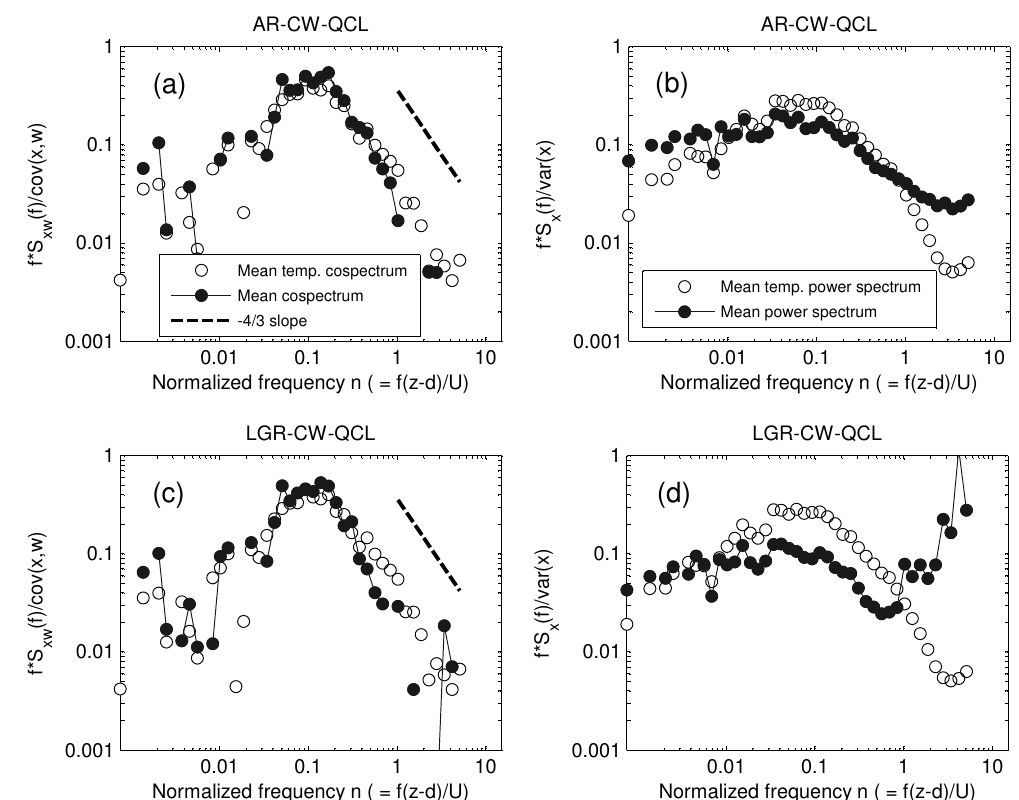
Figure 5. Normalized co-spectra (left panels) and spectra (right panels) of N 2 O measurements by instruments AR-CW-QCL (a, b) and LGR-CW-QCL (c, d) during the period DOY 216 (4 August 2011) 00:30 to 4:00EET. The RCG crop was about 1.8m tall during the given period.